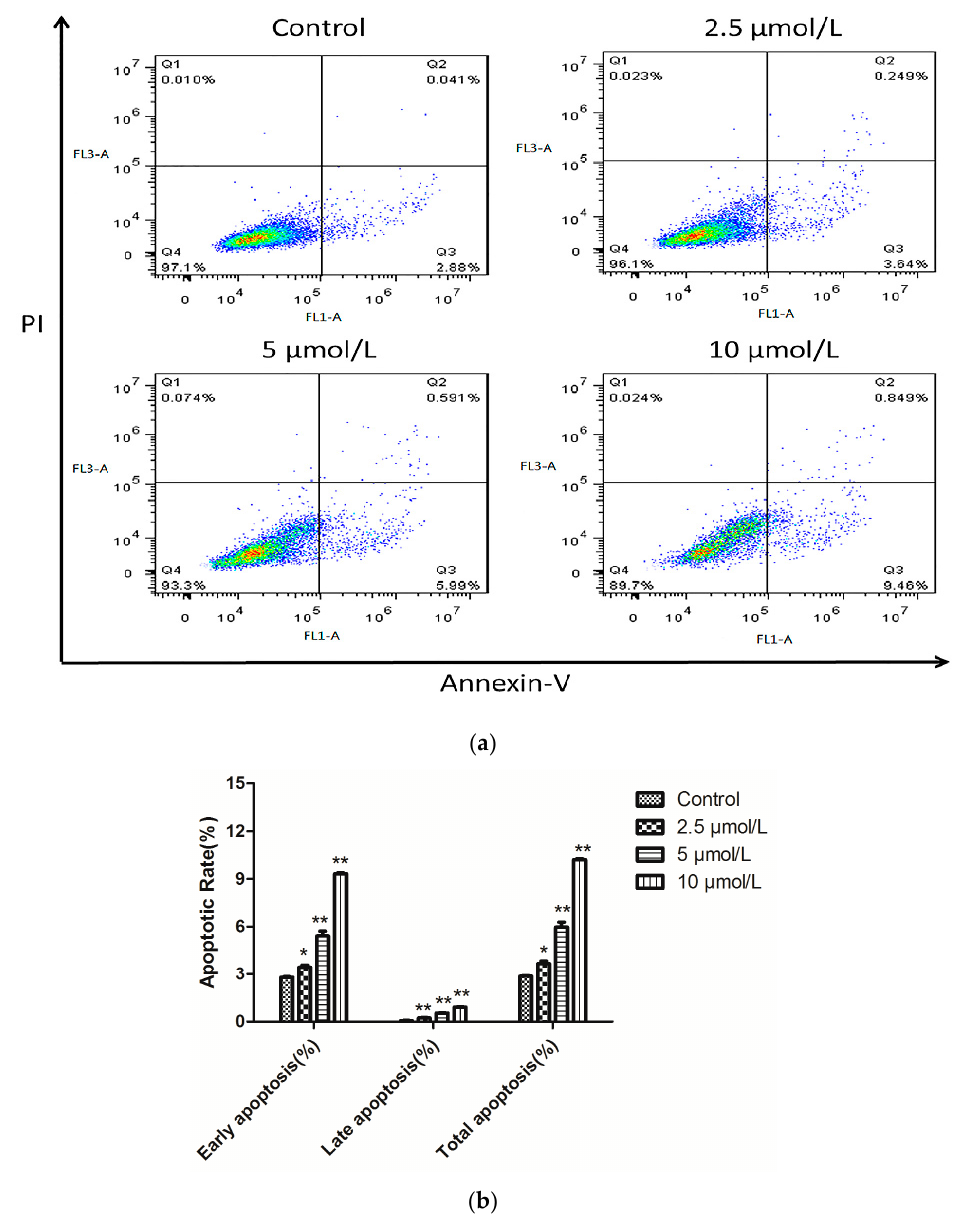
Figure 4. ( a ) Representative flow cytometric histograms of apoptotic HepG-2 cells after a 24 h treatment with compound 1b . The cells were harvested and labeled with Annexin-V-FITC and PI and then analyzed by flow cytometry; ( b ) Quantitative analysis of the number of apoptotic cells. Compared with the corresponding control group, * p < 0.05, ** p < 0.01, ( n = 3).